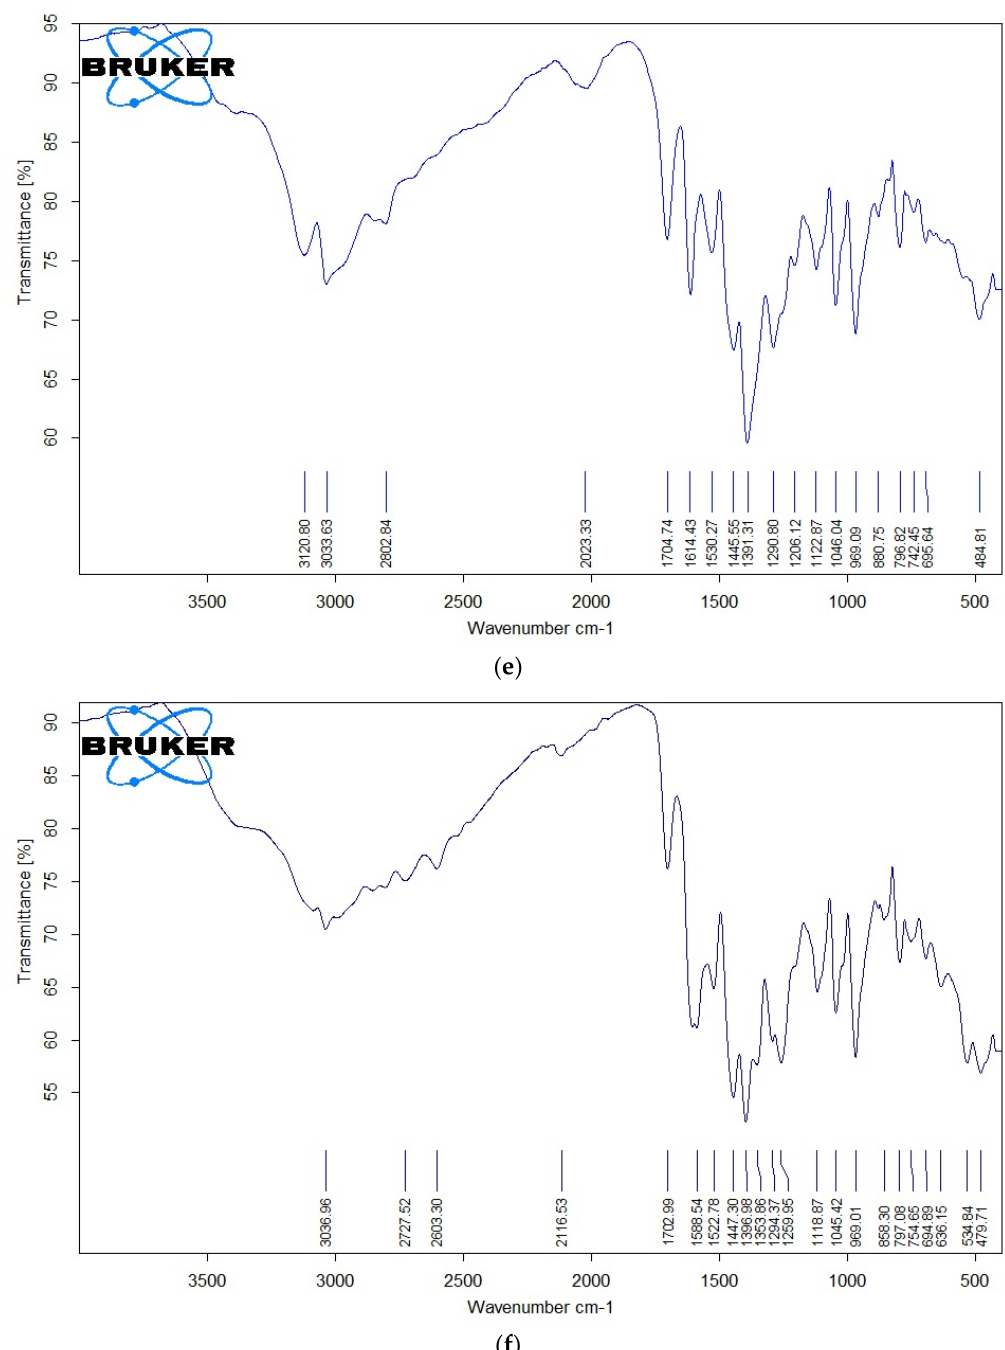
Figure 4. ( a ) FTIR spectrum of free OFL drug; ( b ) IR spectrum of free Gly amino acid; ( c ) IR spectrum of free Ala amino acid; ( d ) IR spectrum of complex 1 ; ( e ) IR spectrum of complex 2 ; ( f ) IR spectrum of complex 3 .